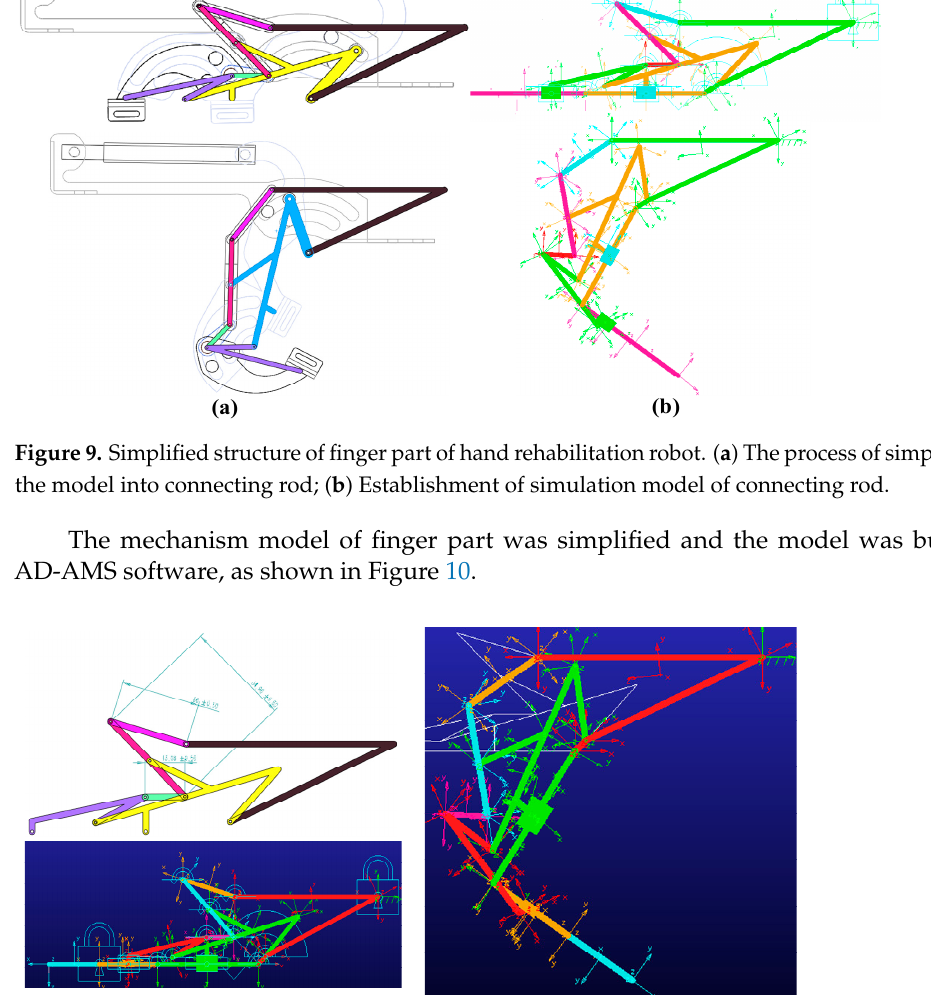
Figure 10. The mechanism model of single finger part.